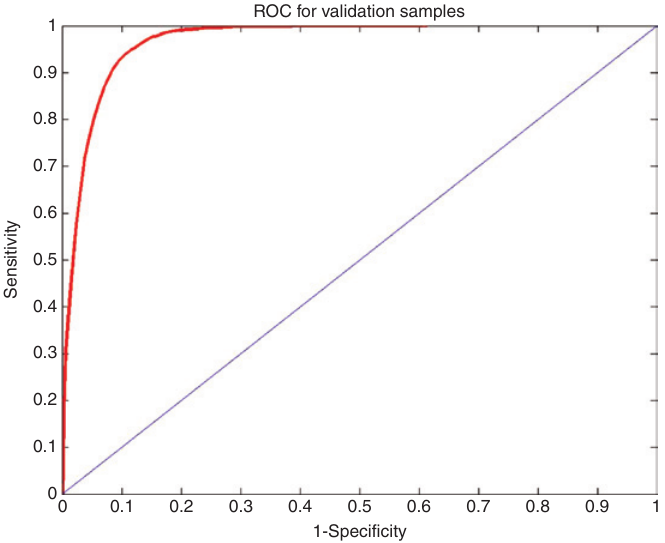
Figure 4. ROC Graph for CbCrRGBHS on Validation Samples.